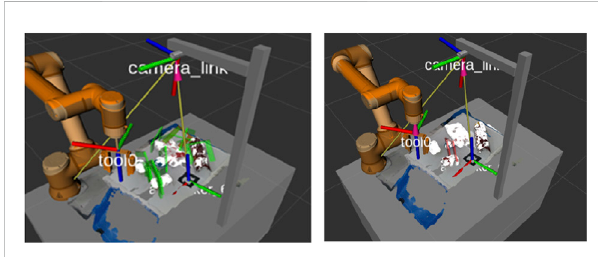
FIGURE 1 Robotic grasping in the cluttered FMCG scenario.